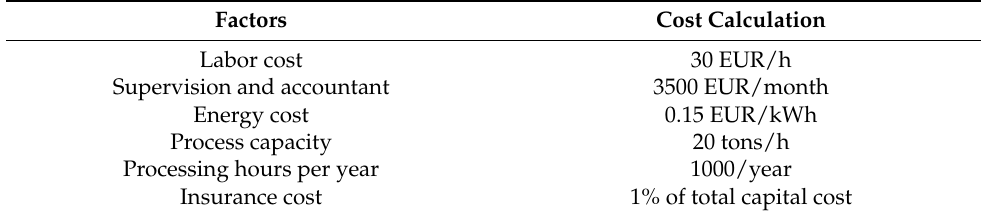
Table 4. Data used to calculate pretreatment operation cost.